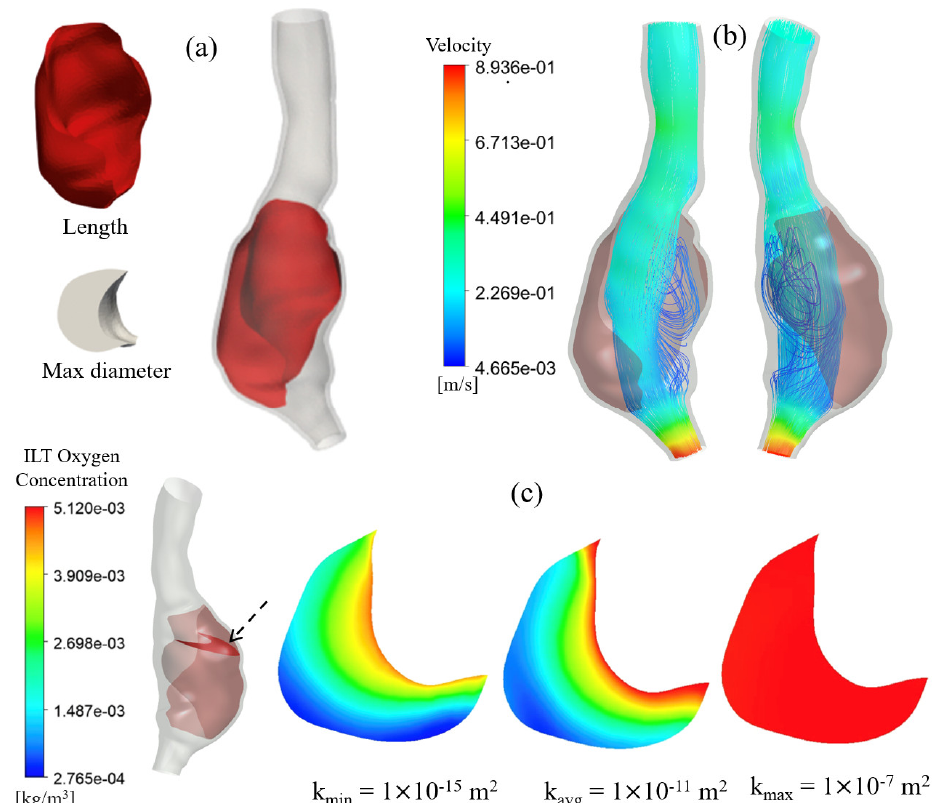
Figure 6. Illustration of ( a ) The patient-specific AAA geometry used in numerical simulations. The lumen and arterial wall are shown in grey, while the ILT is shown in red. See [50] for geometric features of AAA and contained ILT; ( b ) Velocity streamlines through the lumen of the AAA geometry; ( c ) Oxygen concentration contours on a selected ILT cross-section (shown in red and indicated by arrow) for cases with different permeability values.